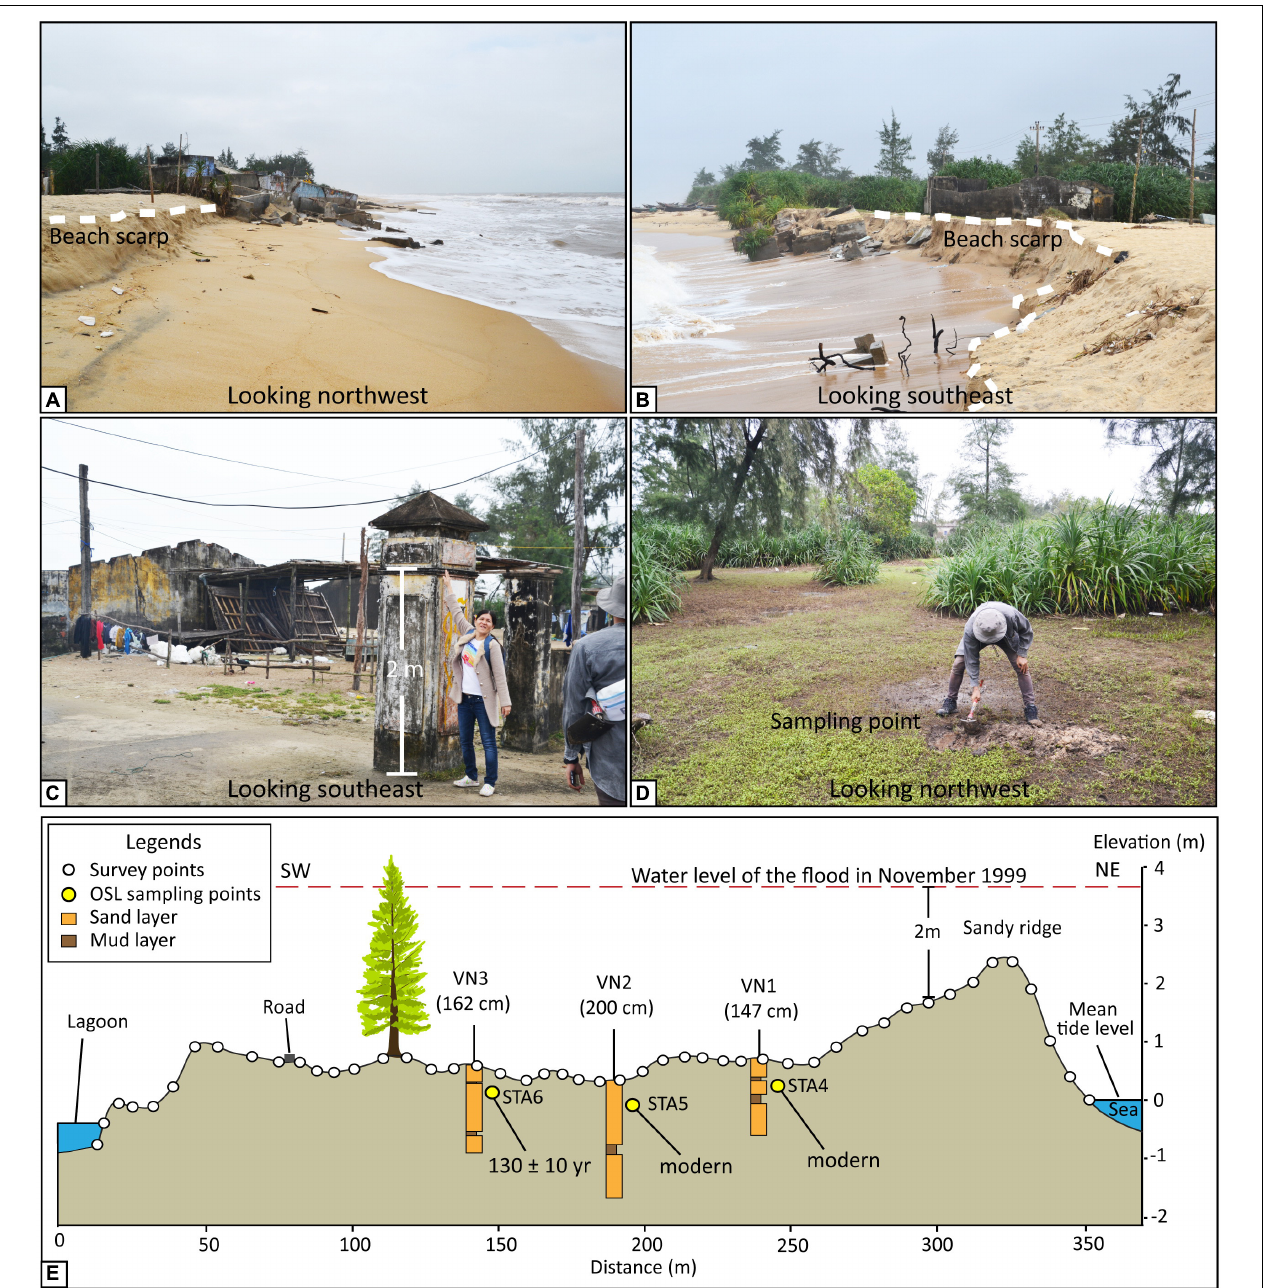
FIGURE 2 | Hoa Duan barrier. (A,B) Beach scarps and derelict buildings resulting from wave erosion during the typhoon season that indicated the maximum wave height during the typhoon season. (C) A local villager showing a water mark level of the flood in November 1999 (2 m). (D) The VN1 and ST4 sampling points in the low topography of the Hoa Duan barrier. (E) Cross-section of Hoa Duan, measured using a total station survey camera, coupled with core locations with depth and the OSL ages (a yellow circle). A dashed red line indicates the water level of the flood in November 1999 that inundated this area (2-m depth). The OSL dating of STA4, STA5, and STA6 indicated the depositional ages as modern, modern, and 130 ± 10 years, respectively. The modern age means less than 100 years. The correlations are presented in detail in Figure 3 . All photos were taken on January 12,